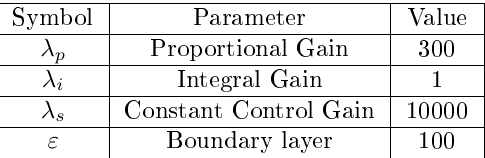
Fig. 6: Error for step response. Table 3. Parameters of the discrete sliding